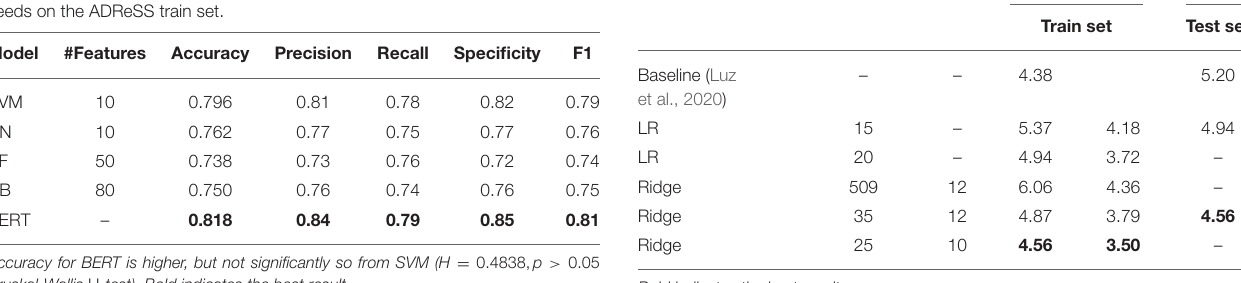
TABLE 8 | AD detection results on unseen, held out ADReSS test set averaged over three runs with different random seeds. Model